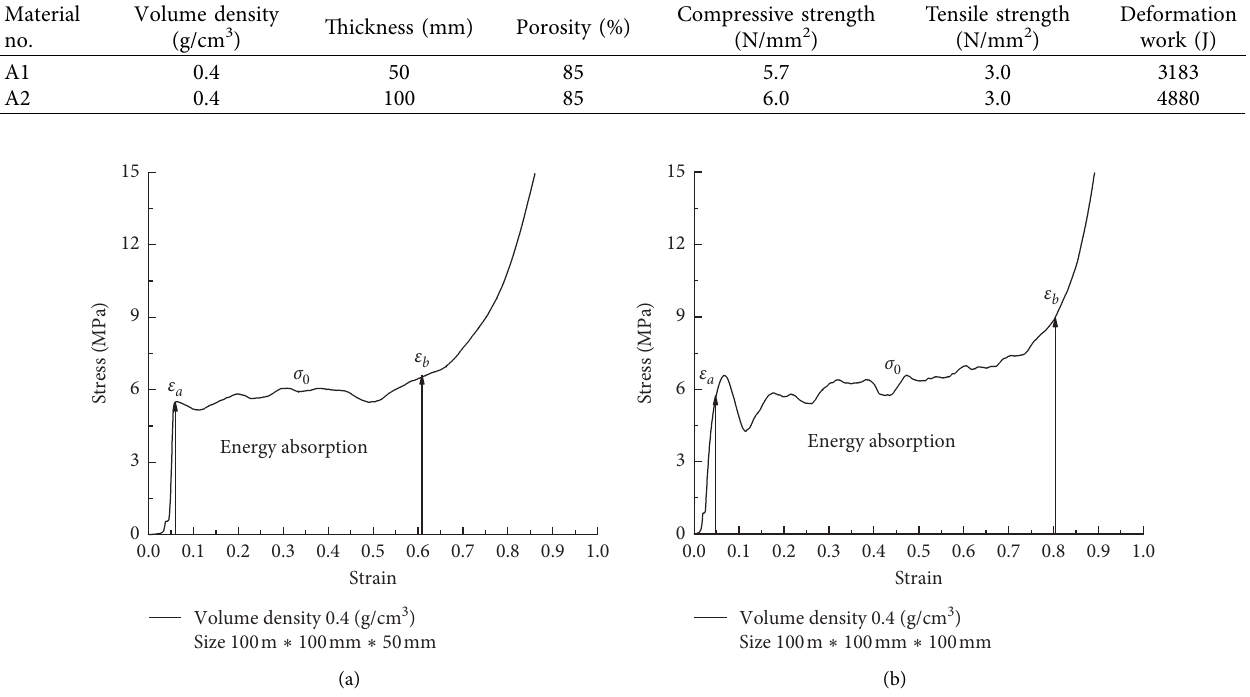
Table 1: Parameters of the closed-cell aluminum foam material.